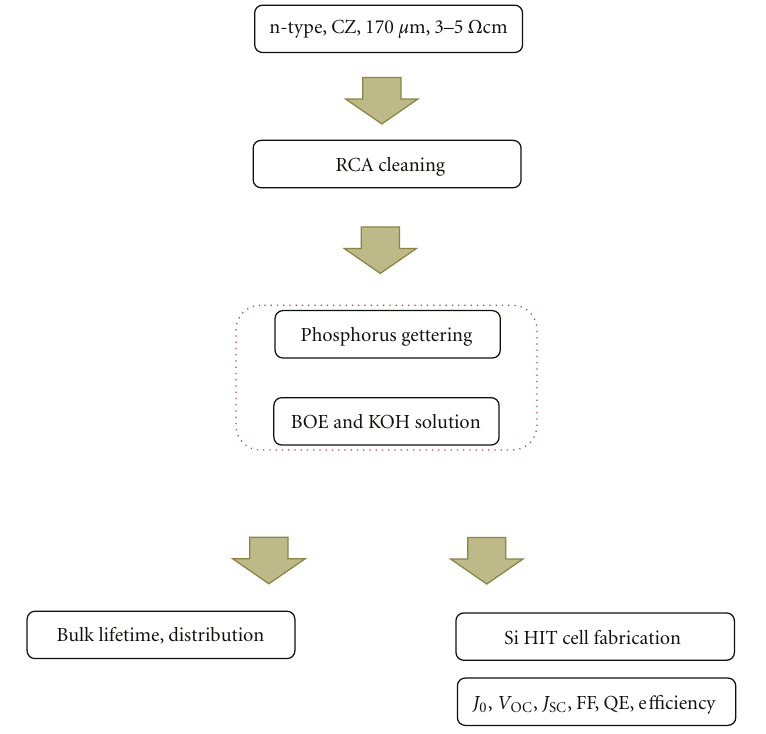
Figure 1: Processing sequence of samples for analysis.